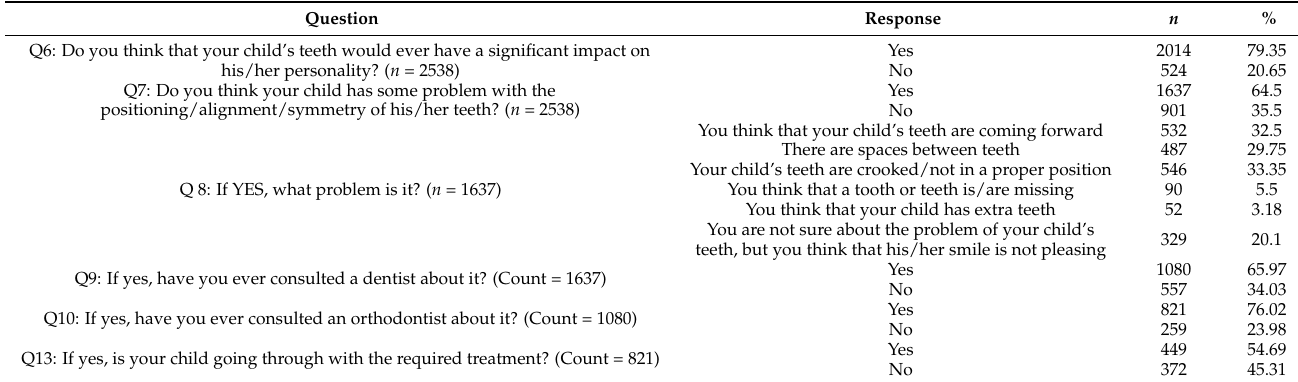
Table 2. Responses of the participants regarding the perceived dental and orthodontic needs and consultation.